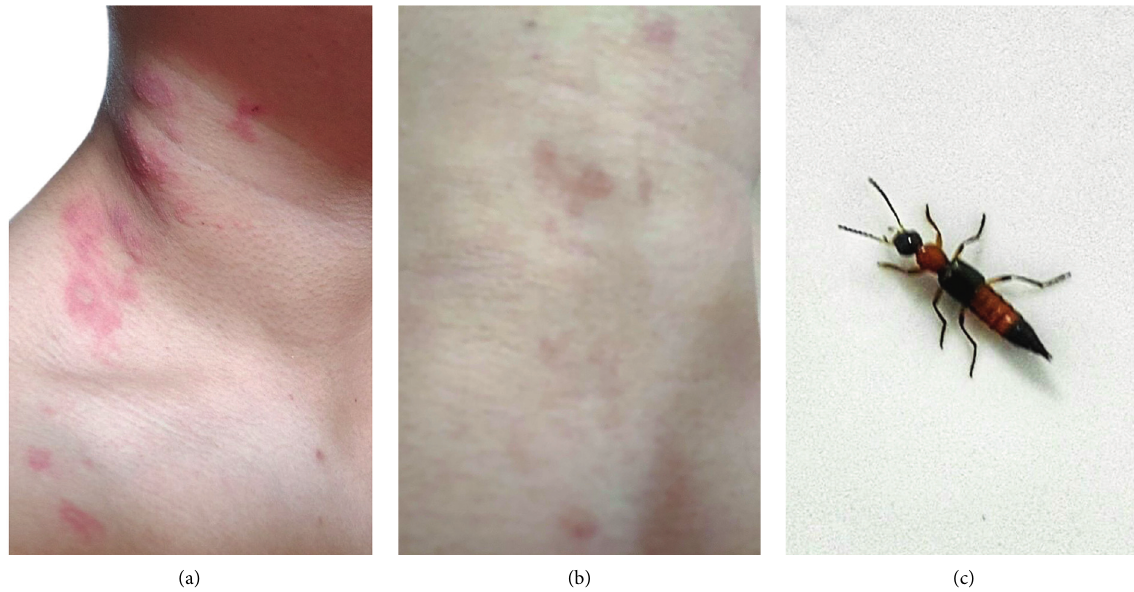
Figure 1: A typical burnt-like lesion of Paederus dermatitis. (a) Linear well-defined erythematous and edematous plaques were presented at patient’s right side of neck. (b) Complete resolution with small degree of hyperpigmentation was observed within 14 days. (c) A photo of suspected Paederus beetle was taken by the patient.